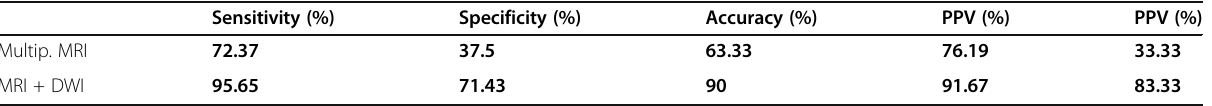
Table 5 Validity of multiparametric MRI/DW-MRI in diagnosis of all studied endometrial lesions (no =